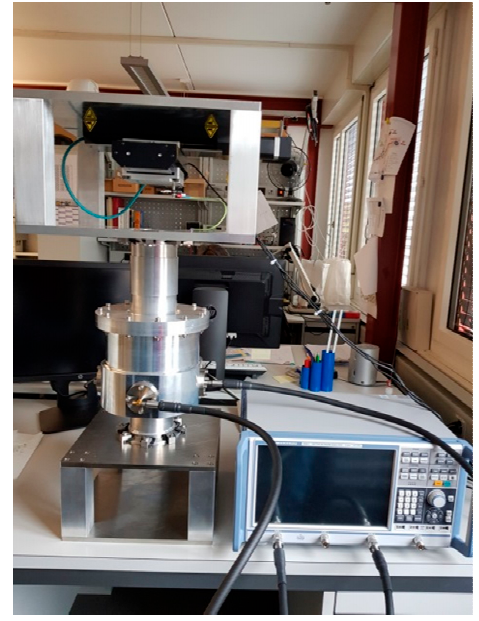
Figure 11. Stand-alone test bench with the working components: FCL100 series linear drives and a ZNB8 vector network analyzer from Rohde-Schwarz.